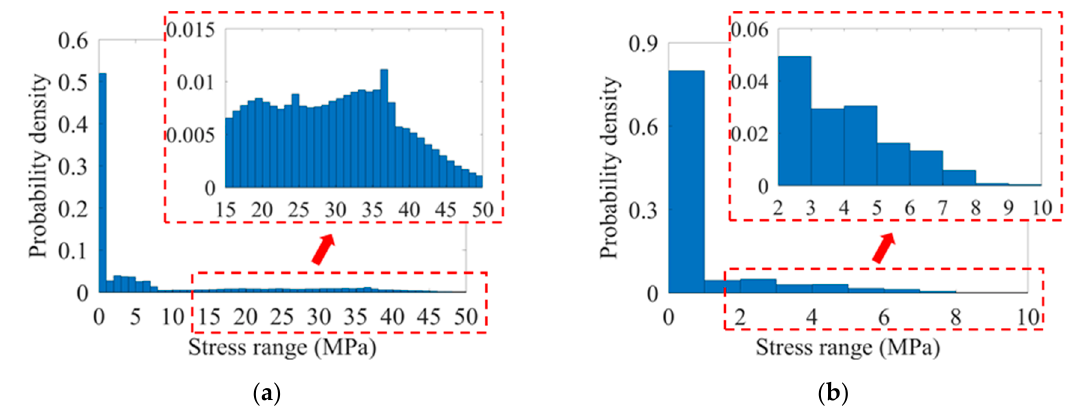
Figure 16. Hot spot stress spectra of the RD joints in different lanes: ( a ) U7 L ; ( b ) U2 L .